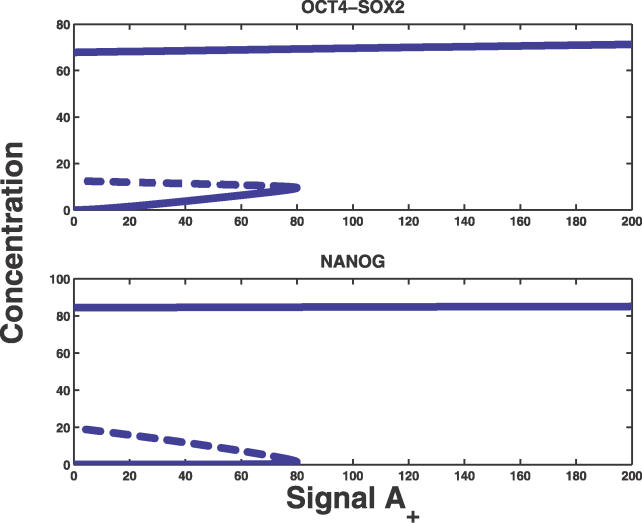
Steady State Concentrations of OCT4–SOX2 and NANOG as Functions of the Signal A
+
There is only one turning point leading to an irreversible bistable switch. At the threshold A
+
≈ 80, the system switches on and remains on even when the stimulus is removed.